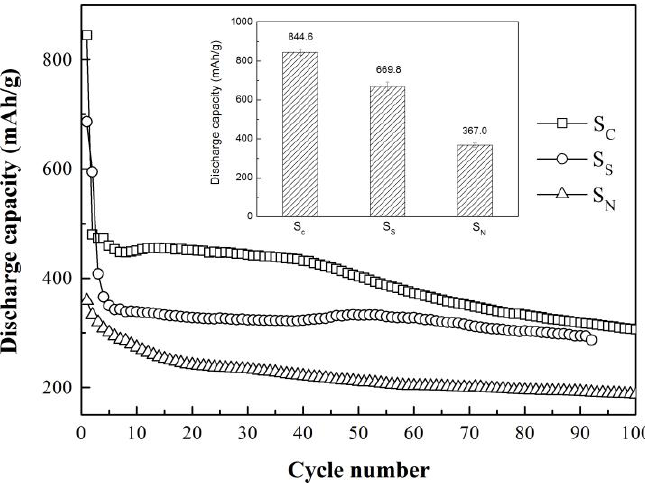
Figure 2. Cycling life of Co-B alloys as the anodes. The inset shows the maximum discharge capacity.